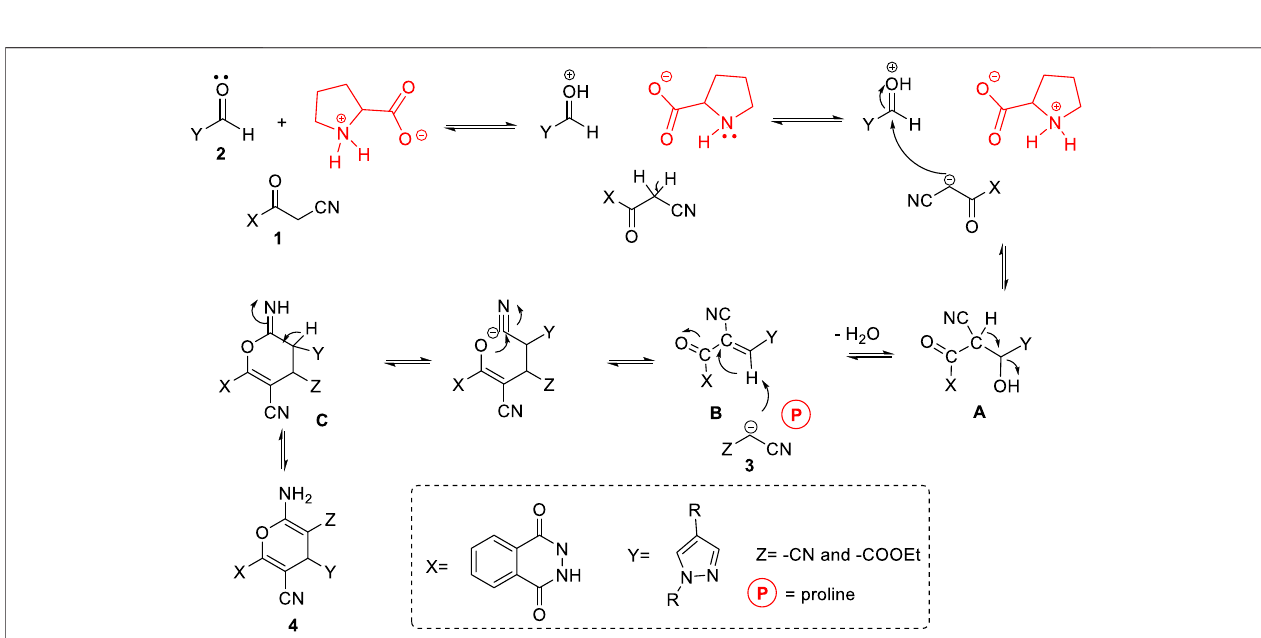
FIGURE 2 | Plausible mechanism of formation of pyran-linked phthalazinone-pyrazole hybrids.